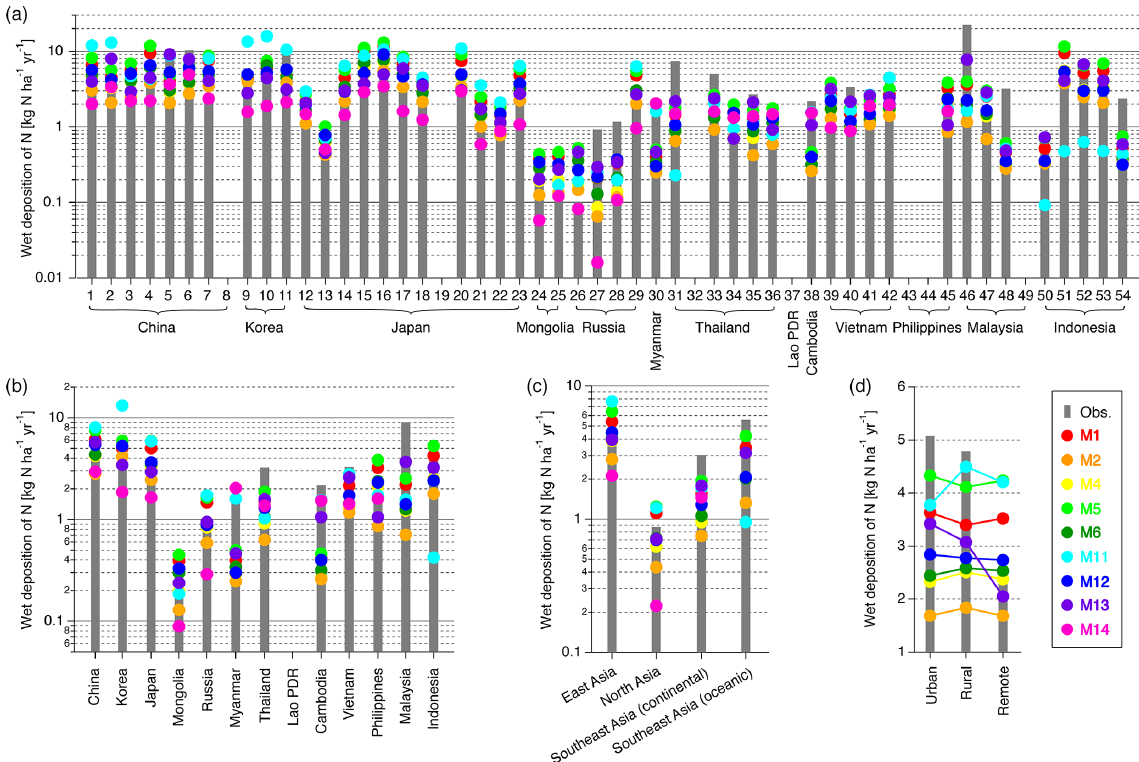
Figure 5. Model evaluation of the annual accumulated wet deposition of nitrate aerosol, nitrogen monoxide (NO), nitrogen dioxide (NO 2 ), and nitric acid (HNO 3 ) (N) (a) at each EANET observation site, (b) for countries, (c) over four defined regions, and (d) over different site